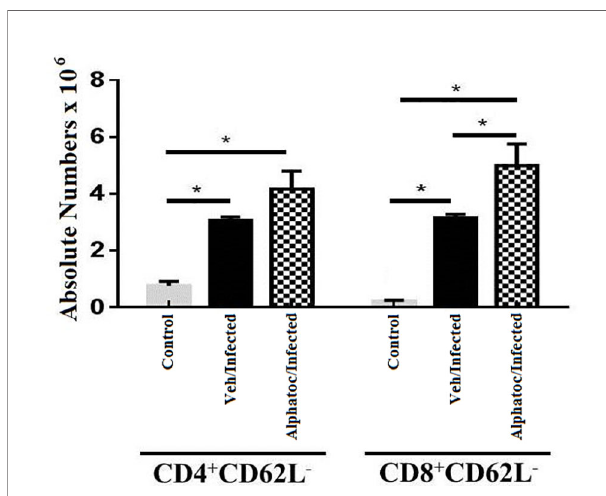
FIGURE 3 | Quanti fi cation of splenic effector memory splenic T cells. Absolute numbers of splenic effector memory T cells in (CD4 + CD62L - or CD8 + CD62L - after 60 days of infection with 10 3 forms are shown (*P < 0,05, Mann Whitney test, n=4). Vehicle and alphatoc pretreated and infected groups were compared. A third untreated group was used as a control. Data are for one representative experiment out of three.